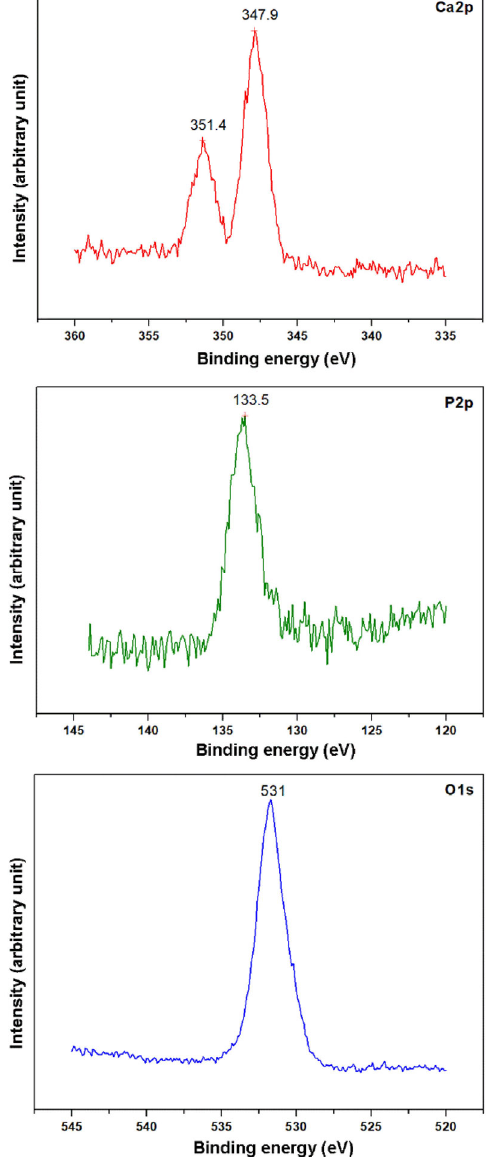
Fig. 10 Ca2p, P2p, and O1s XPS narrows pectra of ATF-B